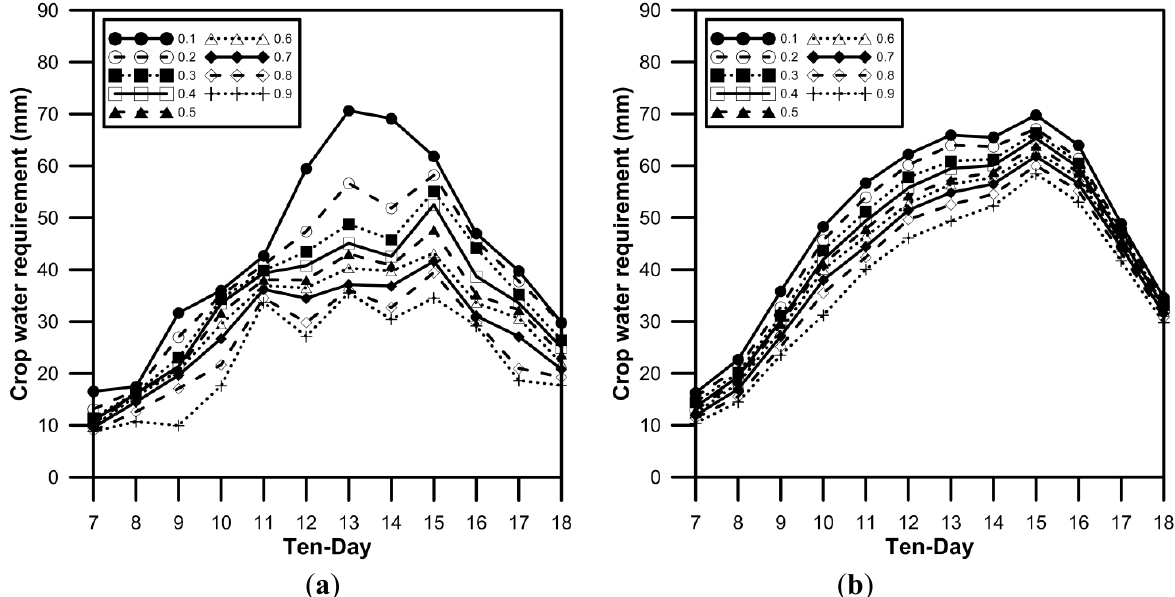
Figure 11. Exceedance probability distribution of crop water requirement at each ten-day during the first cropping season. ( a ) present (2004–2011); ( b ) future